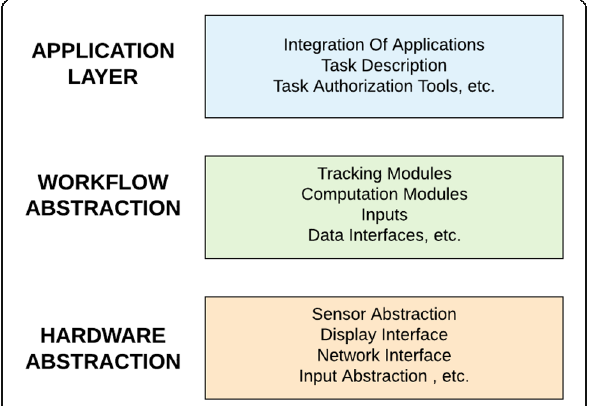
Fig. 2 Framework for AR in mobile